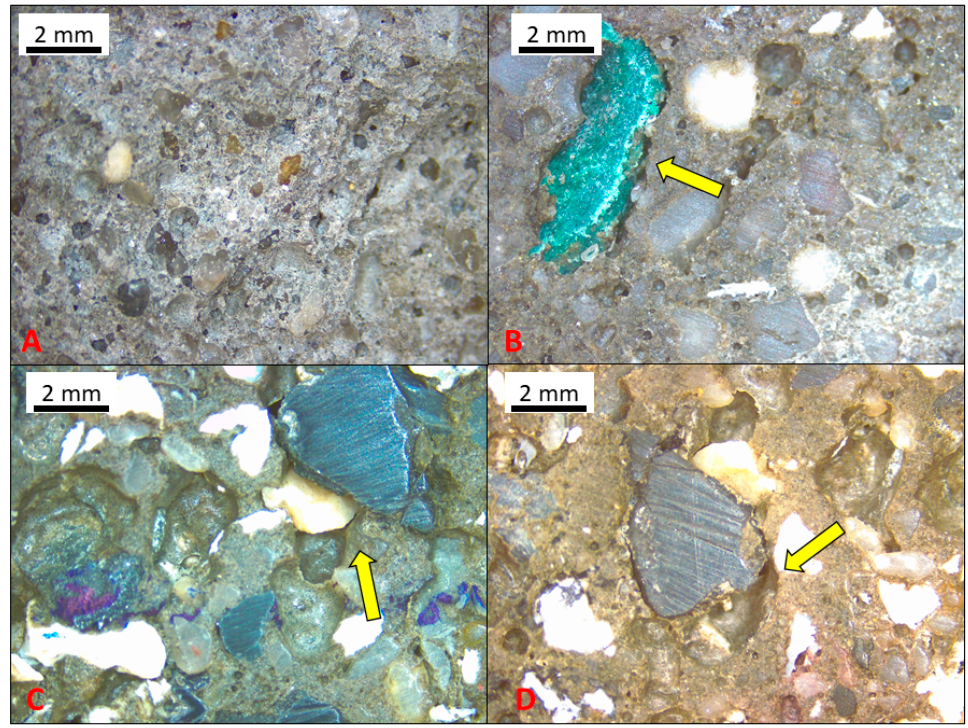
Figure 2. Stereomicrographs of mortars ( A ) 0 PW, ( B ) 30 PW ( C ) 60 PW and ( D ) 90 PW; yellow arrow indicates the lack of adhesion.